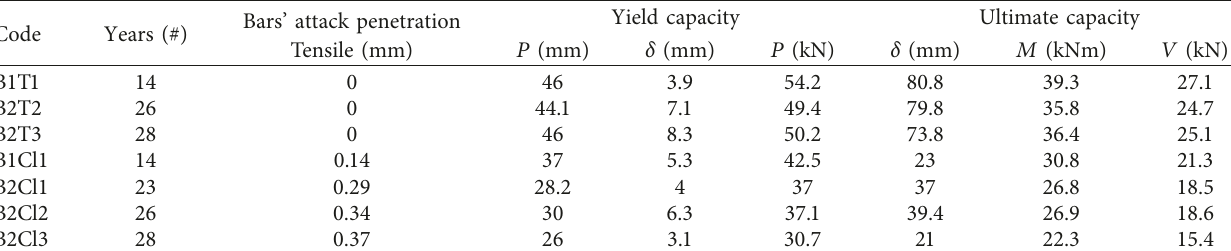
Table 3: Data of specimens tested by Zhu and François [8].